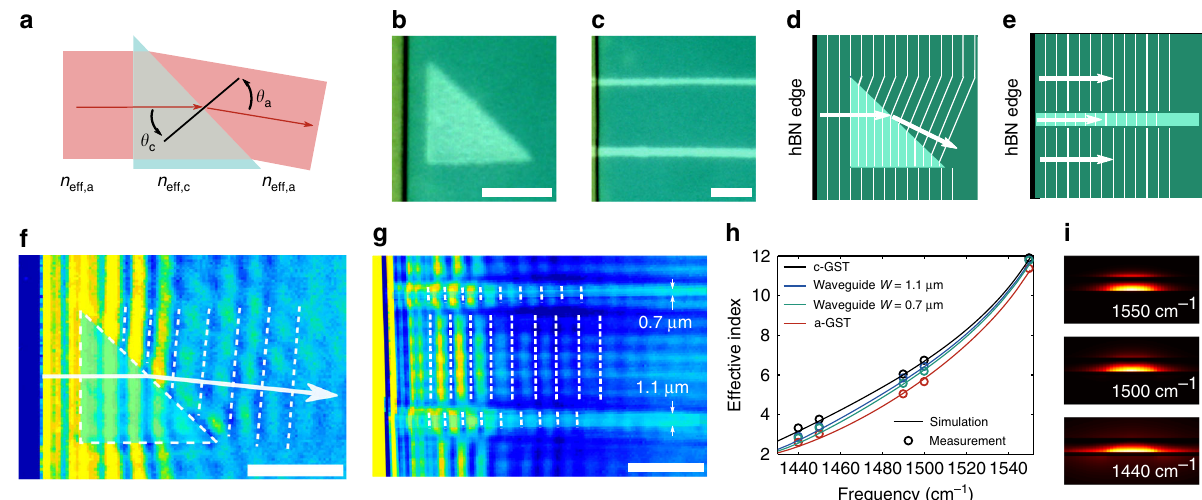
Fig. 3 Prism and waveguides. a Snell ’ s law for 2D prisms determines de fl ection of polaritons. b Optical image of the written prism, an isosceles right-angled triangle with edges of 7.5 µ m. The fl ake edge is also visible. c Optical image of the written waveguides (top 0.7 µ m wide, bottom 1.1 µ m wide). The distance between the waveguides is 8.5 µ m, which ensures no coupling between them. d Diagram of wavefronts for the prism. e Schematics of wavefronts for a waveguide. Polaritons propagating inside the waveguide have smaller fringe spacing due to the additional con fi nement of the waveguide mode. f s-SNOM image of prism showing a clear de fl ection angle of the outgoing wavefronts. g s-SNOM image of waveguides, showing the expected con fi nement of the modes inside of them. The fringe spacings are different for waveguides with different widths, con fi rming that the spacing is determined by the mode of the waveguide. h Simulated and measured effective indices of the waveguides. The effective indices are between n eff , a and n eff , c . i Cross-section of the guided mode of the 0.7 µ m waveguide at different frequencies (out-of-plane Poynting vector). Scale bars are 5 µ